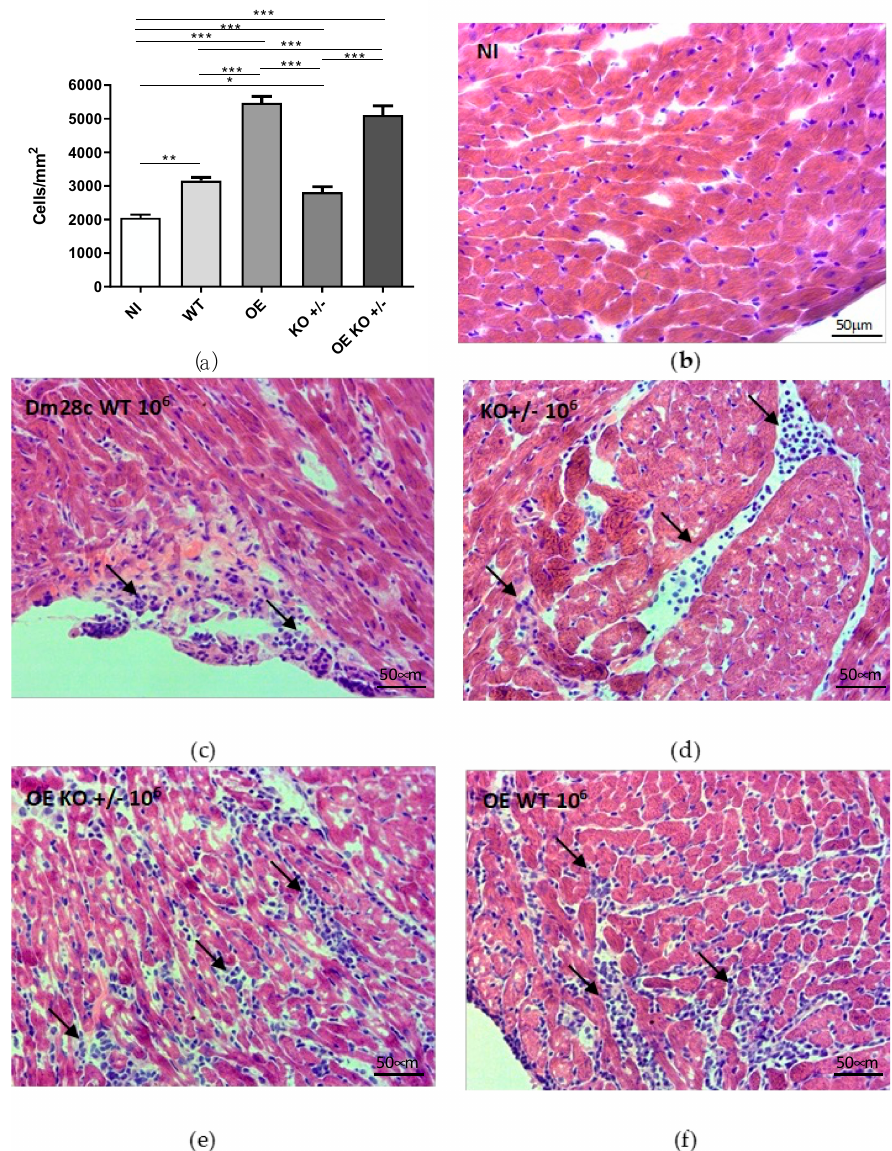
Figure 3. Quantitative histopathological analysis of heart sections of mice non-infected (NI) or infected with (wild type) WT, (overexpressed) OE, (hemi-knockout) KO +/ − , and (overexpressed hemi-knockout) OE KO +/ − . Hematoxylin and eosin stained at 30 dpi. ( a ) Quantification of the number of cell nucleus per mm 2 . ( b – f ) Histological sections of the animals’ hearts, demonstrating the areas of inflammatory infiltrate in the different infection groups at 30 dpi. * p < 0.05; ** p < 0.01; *** p < 0.001 (one-way ANOVA with Holm-Sidak post-test). Arrows indicate the carditis areas.